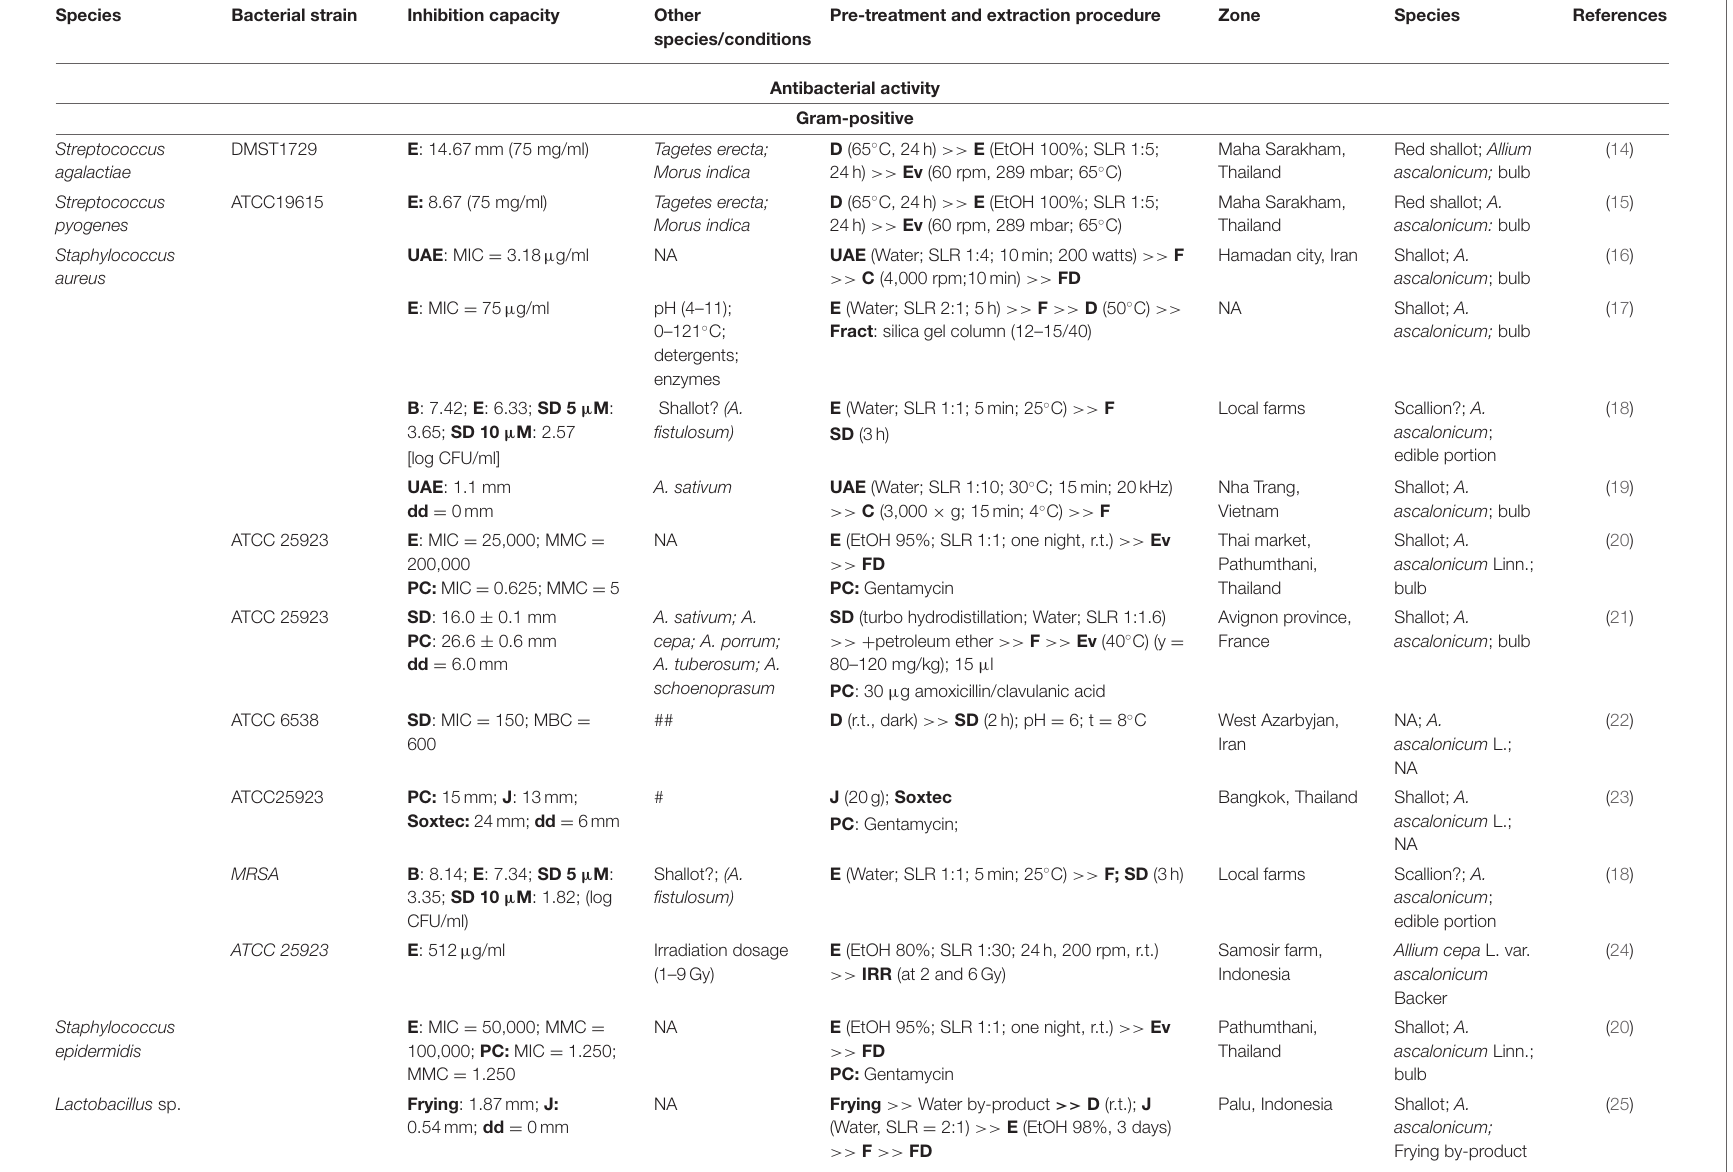
TABLE 1 | Summary of main antibacterial, antifungal, antiprotozoal, and antiviral activity exerted by shallot extracts.